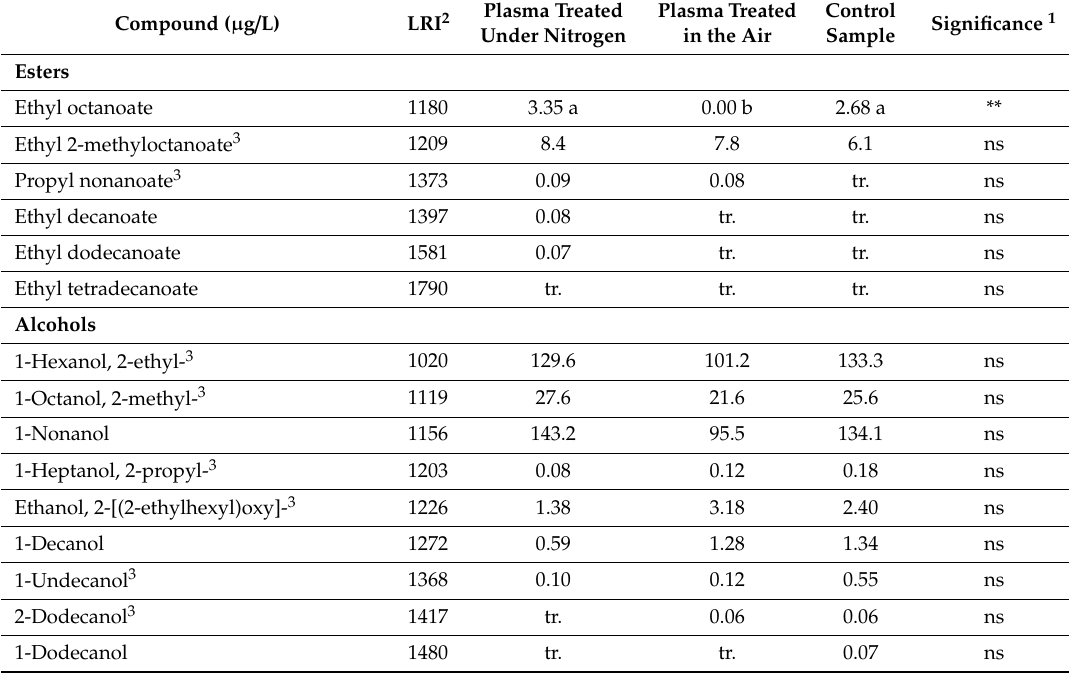
Table 4. Aromatic composition of the obtained hopped